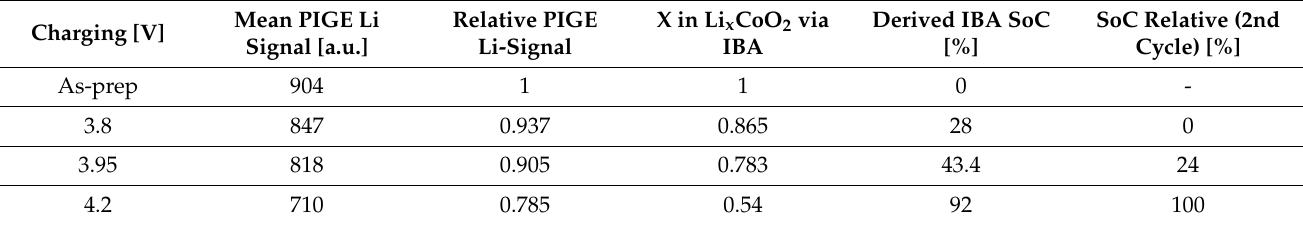
Table 1. IBA results of the LLZ + LCO cells showing a clear decrease of lithium signal with increasing SoC. The four different charge states can be resolved considering uncertainties. The As-prep sample is defined as SoC = 0. Considering the measured irreversible capacity loss in the first cell cycle, compared to As-prep, the SoC of the investigated 2nd cycle increases